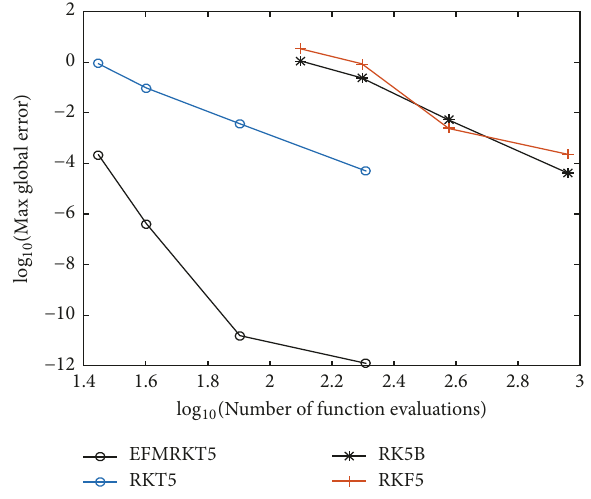
Figure 1: The efficiency curve for EFMRKT5, RKT5, RK5B, and RKF5 for Problem 2 with 𝑥 𝑒𝑛𝑑 = 5 and ℎ = 0.1, 0.25, 0.5, 0.75